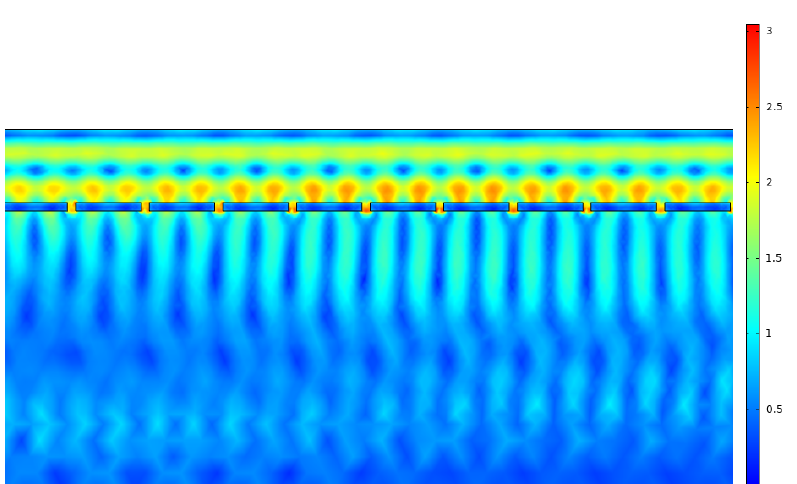
Figure 13. Nanoantenna array influence on the electromagnetic field in the absorber